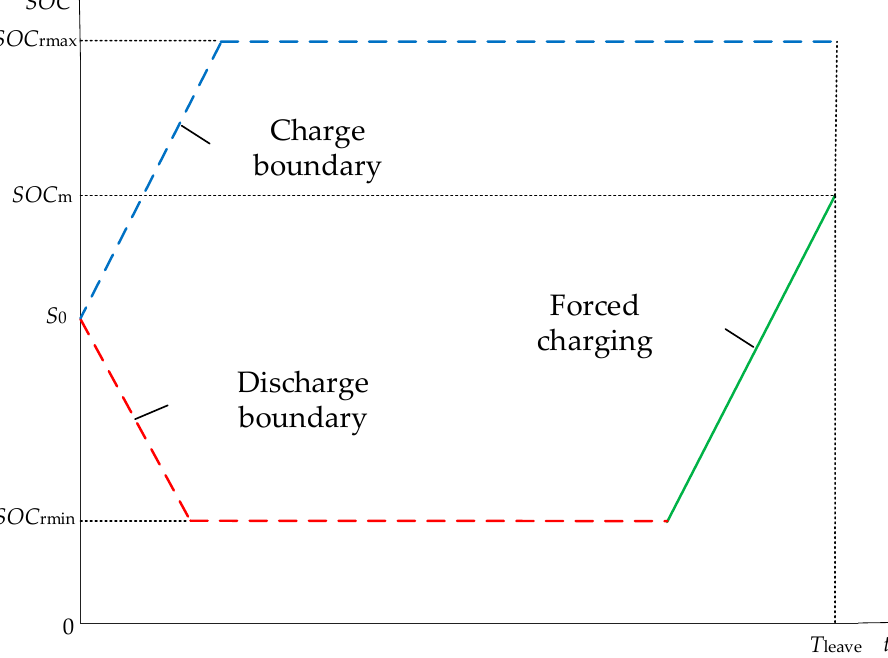
Figure 1. Boundary of charging and discharging constraints for EVs.